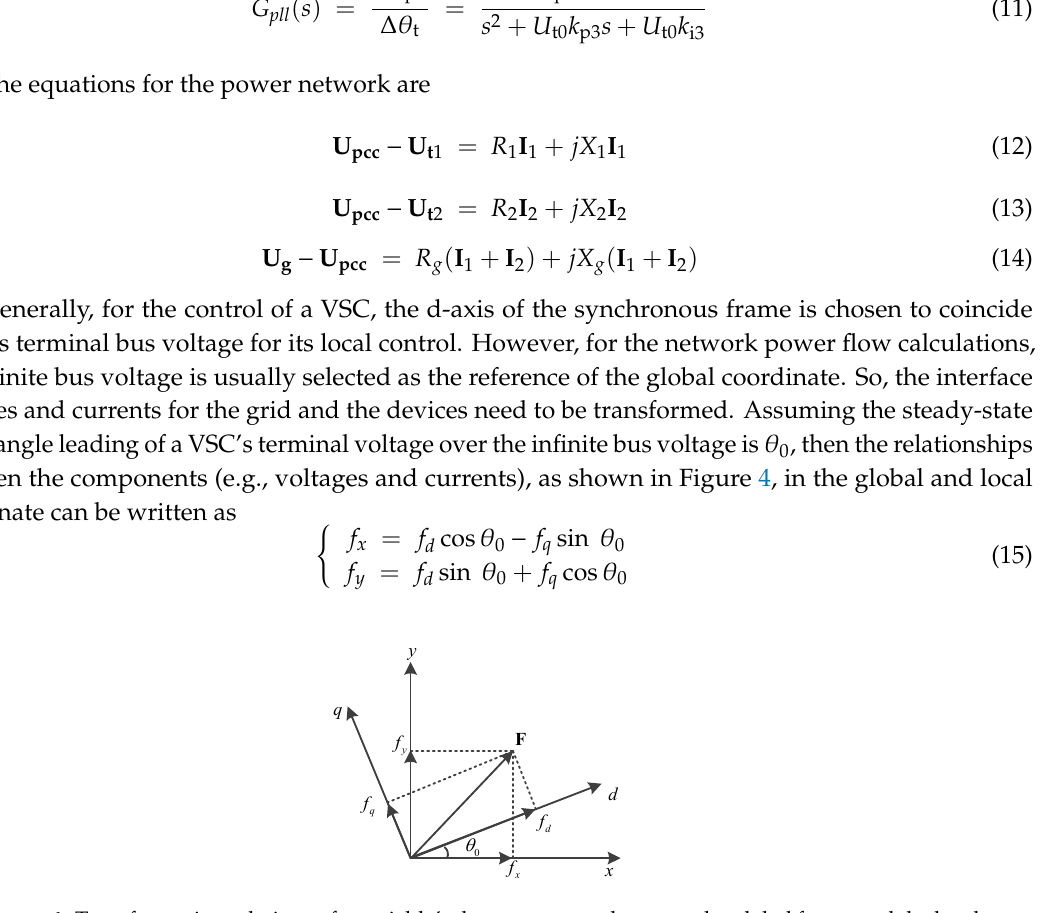
Figure 3. Diagram of PLL model [15]: ( a ) the actual structure of the PLL, ( b ) equivalent formulation in synchronous reference frame.